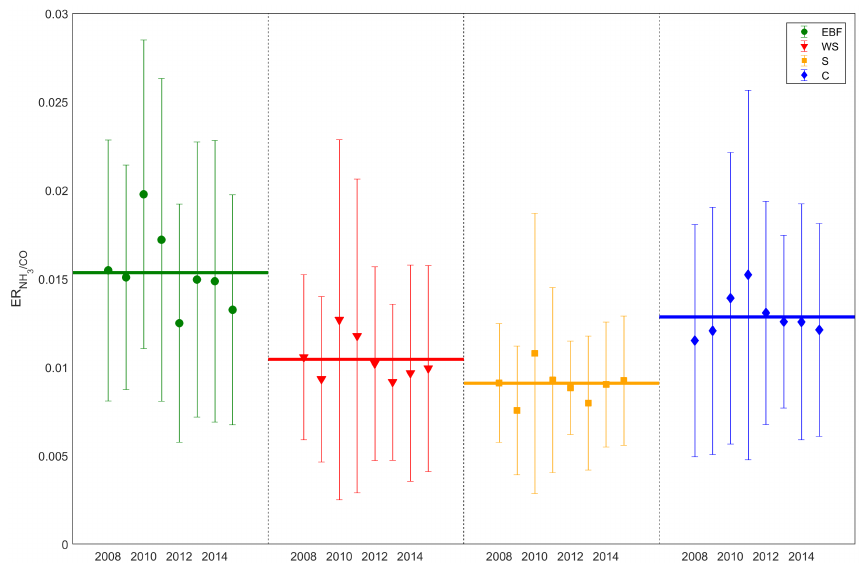
Figure 6. Mean ER NH ratios averaged by biome and by year (2008–2015) from the yearly ER NH 3 / CO selected in Sect. 2.3. The error bar is the 1 σ SD around the mean. The solid line represents the 8-year average per